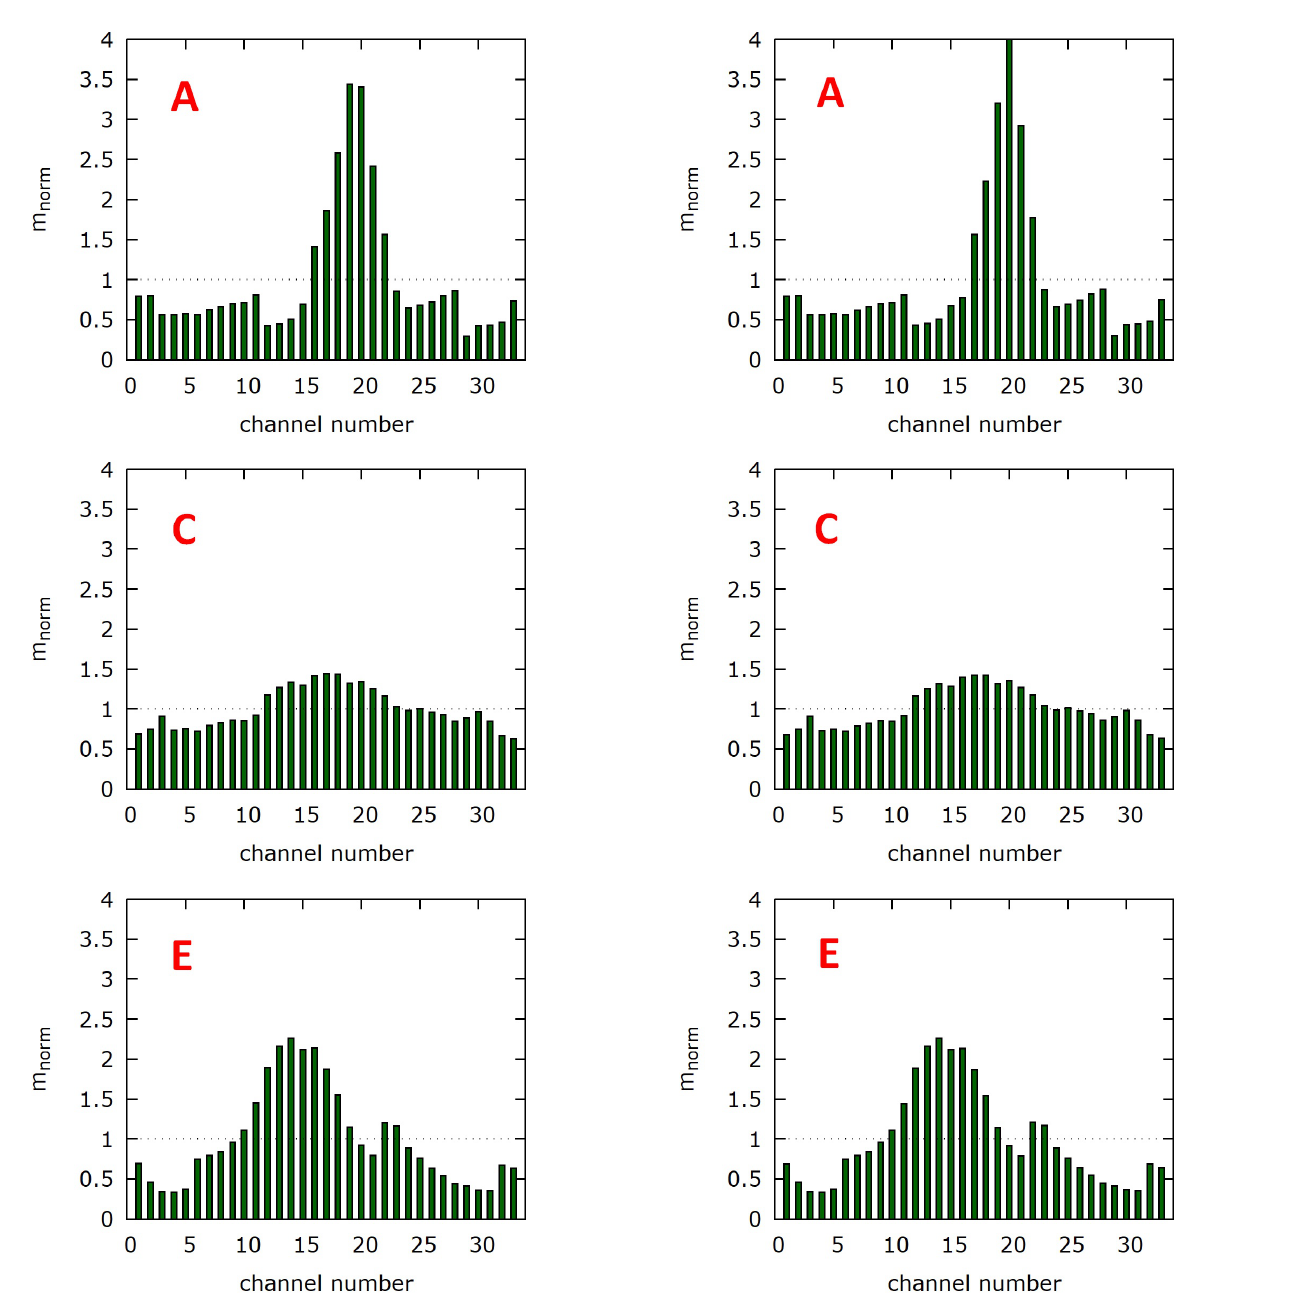
Figure 19. Normalized mass flow at positions A (inlet), C (middle), and E (outlet) for condition MAX. ( Left ) Normal flow at the inlet channels and ( Right ) partial blocking of channel